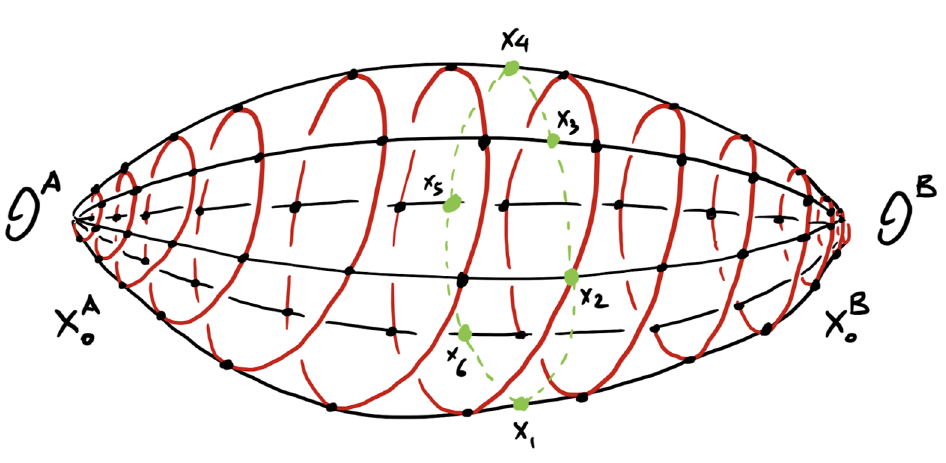
Figure 3 . The scalar product between two wave functions. The (cid:3) factors included in the definition of the scalar product remove some propagators, so that the two wave functions are joined seamlessly without altering the structure of the